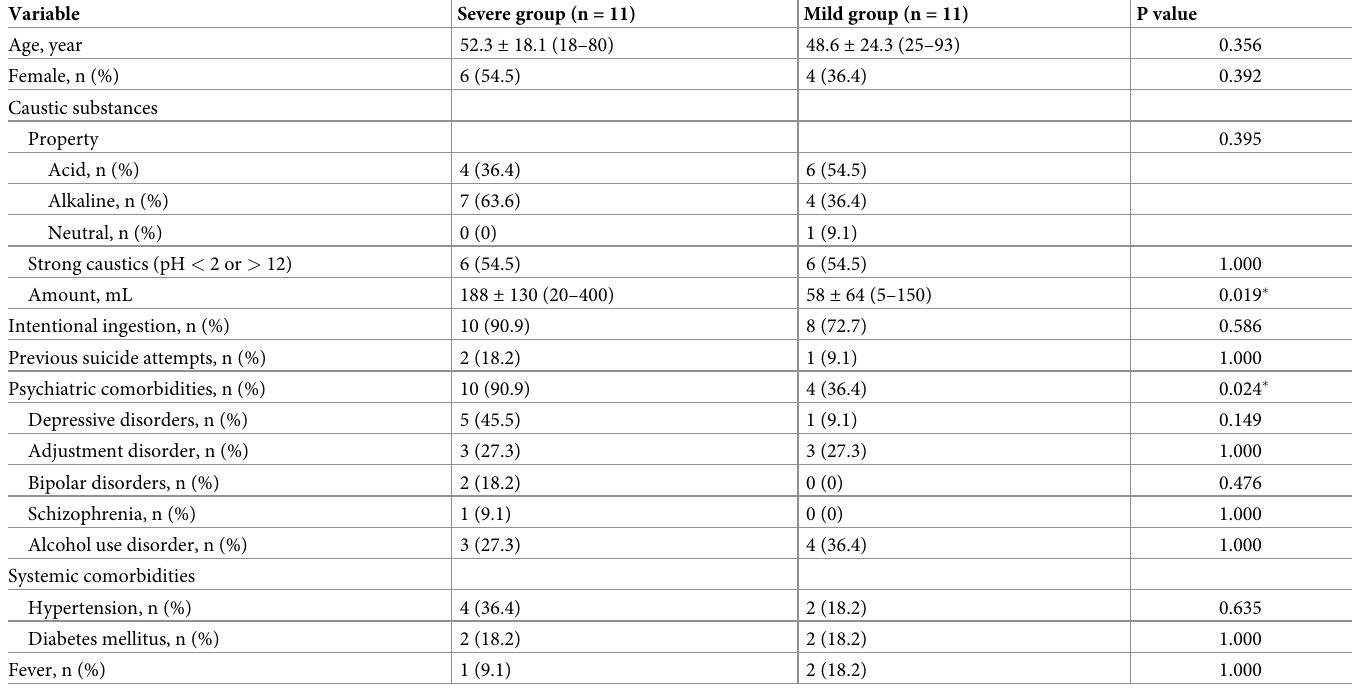
Table 2. Baseline demographics of patients with caustic gastrointestinal tract injury (n = 22).